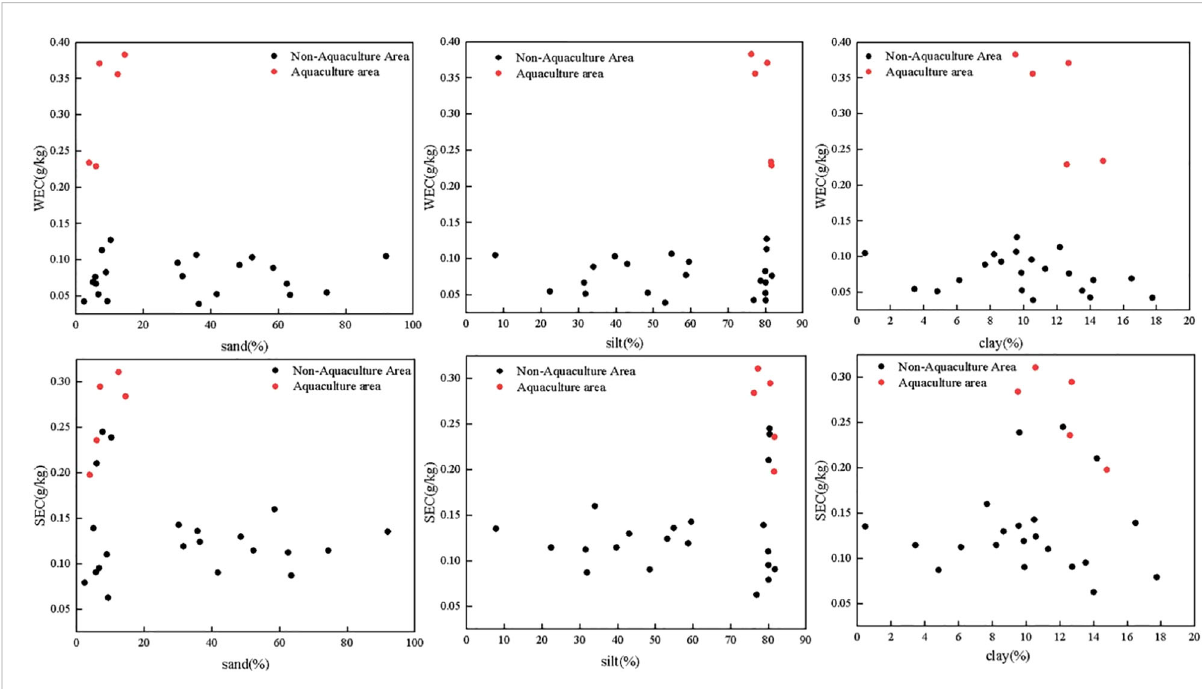
FIGURE 7 Relationship between WEC and SEC and grain size